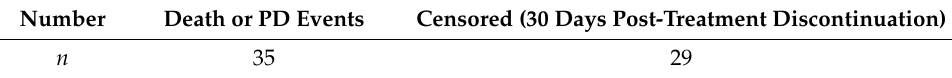
Table 2. Progression-free survival analysis.